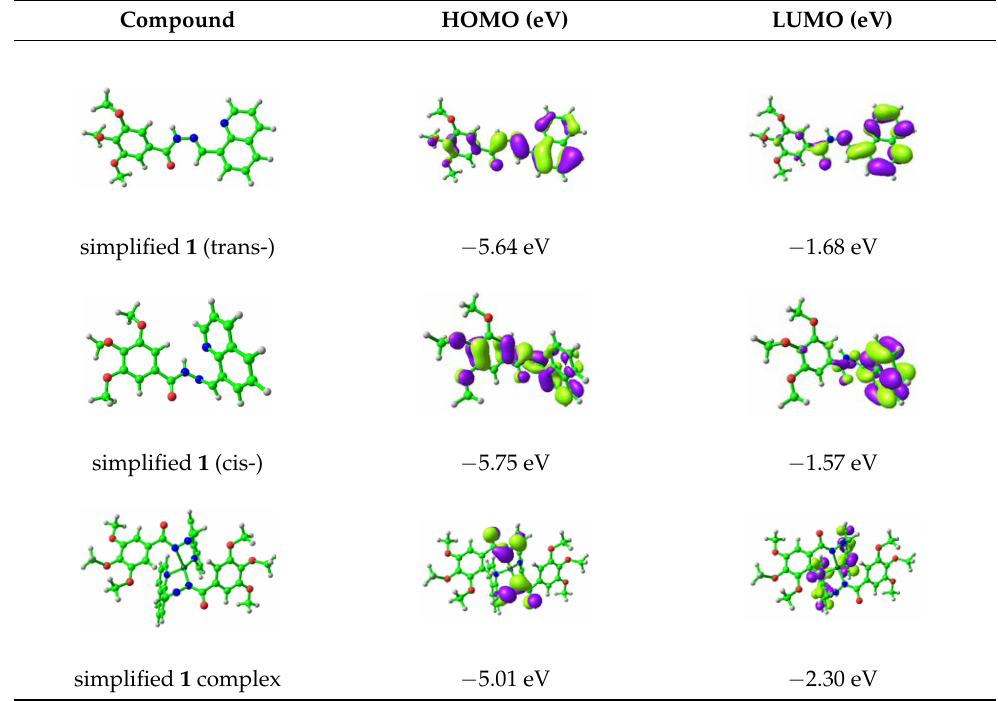
Table 2. Structures of simplified compound 1 , complex and their corresponding the frontier